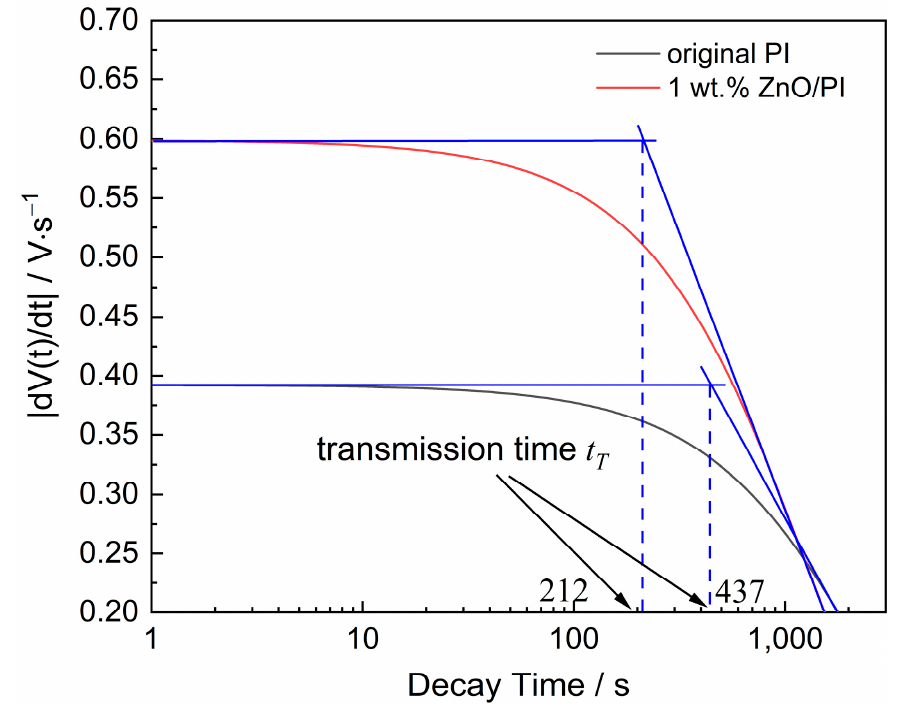
Figure 10. The surface potential decay rate of original PI and 1 wt.% ZnO/PI. Table 4. The carrier mobility variation in composite films with different amounts of nano-ZnO.